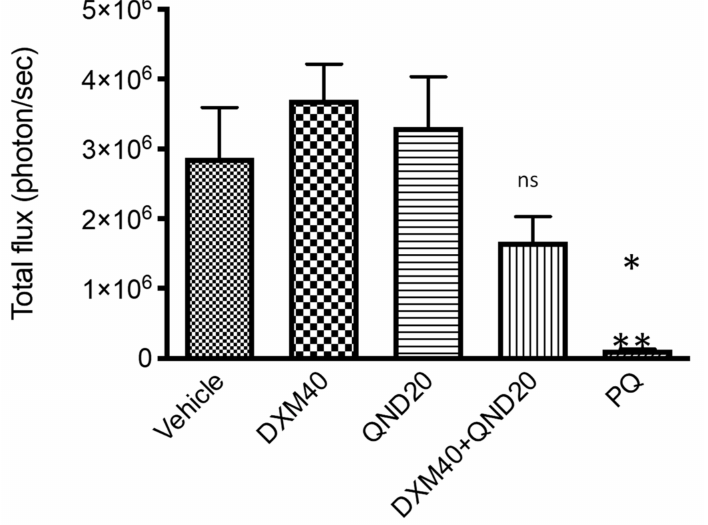
Figure 3. In vivo prophylactic activity of DXM 3 +/ − QND compared to PQ in a mouse model of P. yoelii -Luc infection. Each group of mice consisted of five individuals. Results are shown as mean +/ − SEM: Vehicle vs. DXM40 + QND20, p = 0.5171 (ns, not significative); Vehicle vs. PQ, p = 0.0124 (*); DXM40 vs. PQ and QND20 vs. PQ, p = 0.003 (**). ANOVA one-way test for multiple comparisons. Numeric values indicate doses in